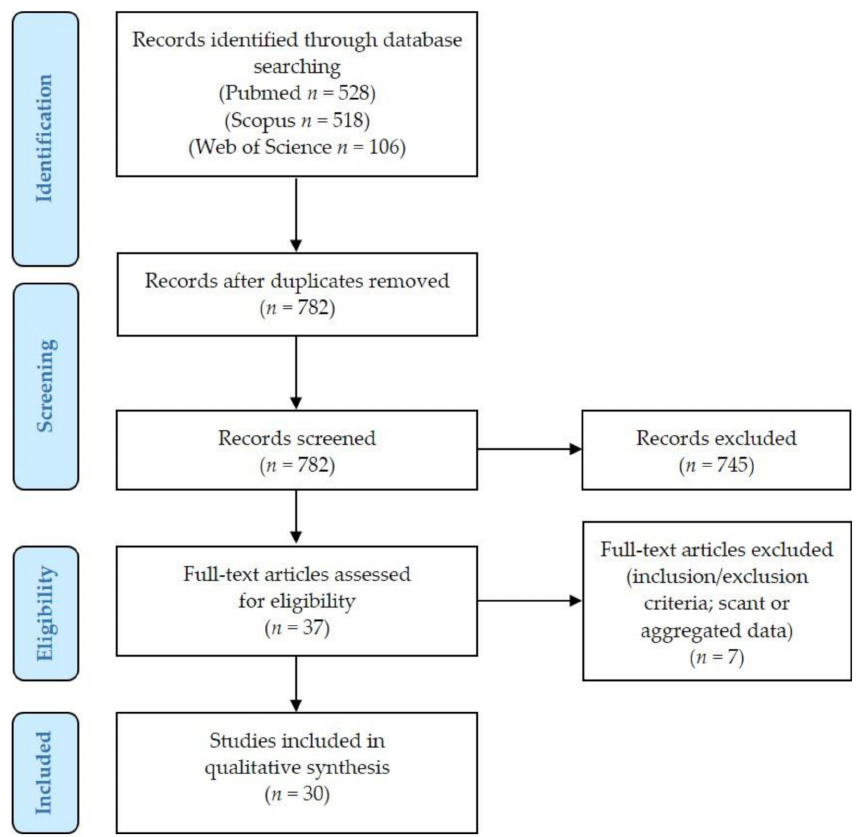
Figure 1. Review of the literature: Preferred Reporting Items for Systematic Reviews and Meta-Analyses (PRISMA) flow